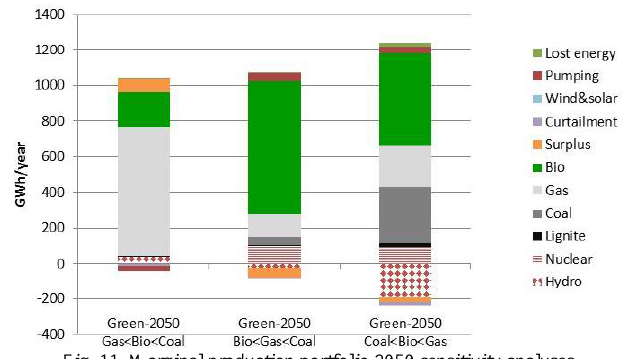
Fig. 11. Marginal production portfolio 2050 sensitivity